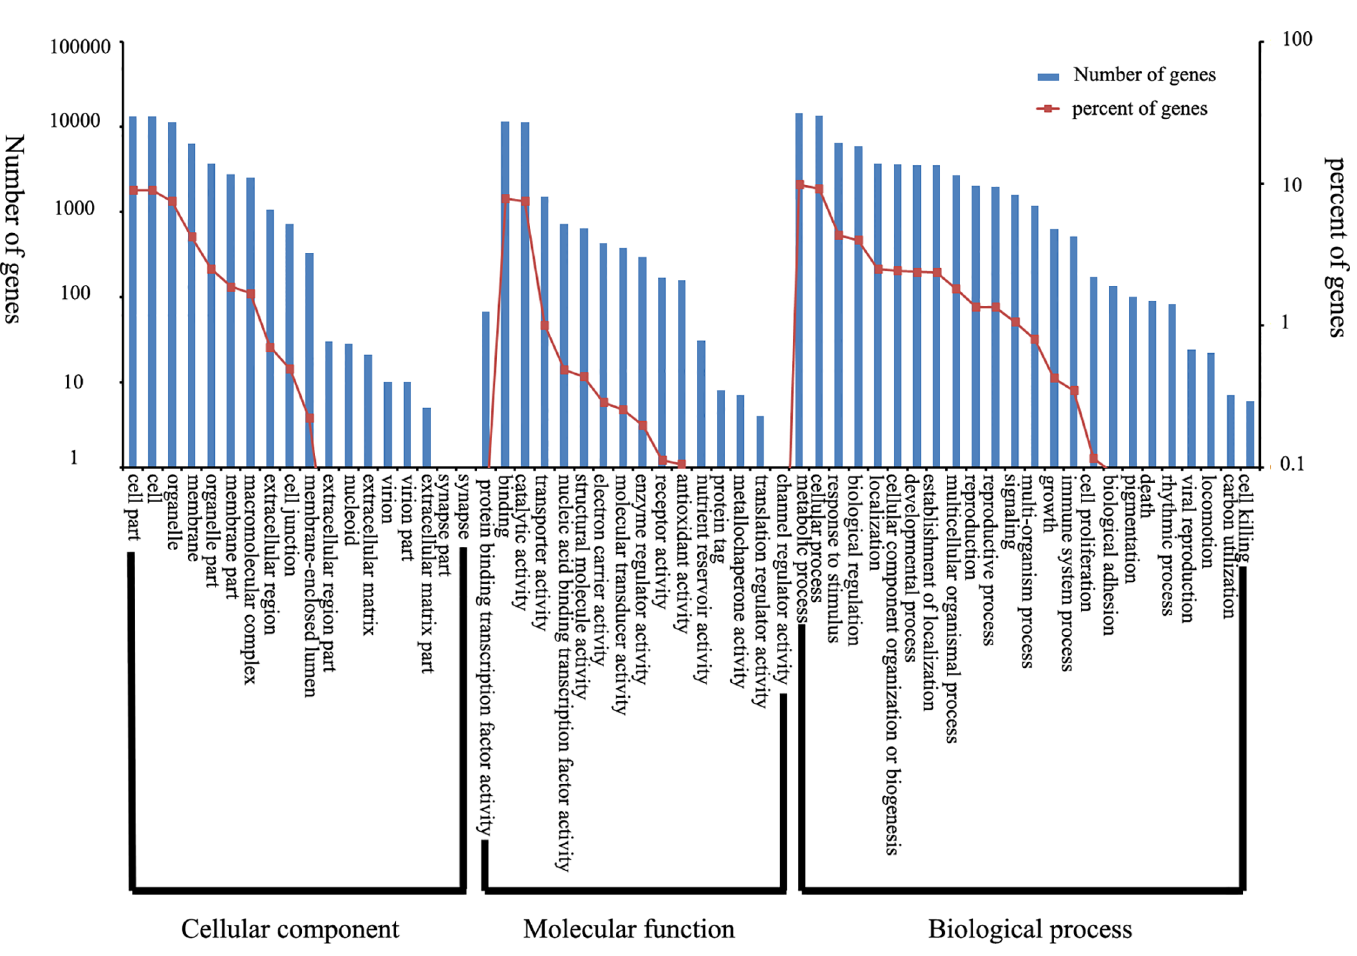
Fig 3. Functional annotation of unigenes based on GO categories.